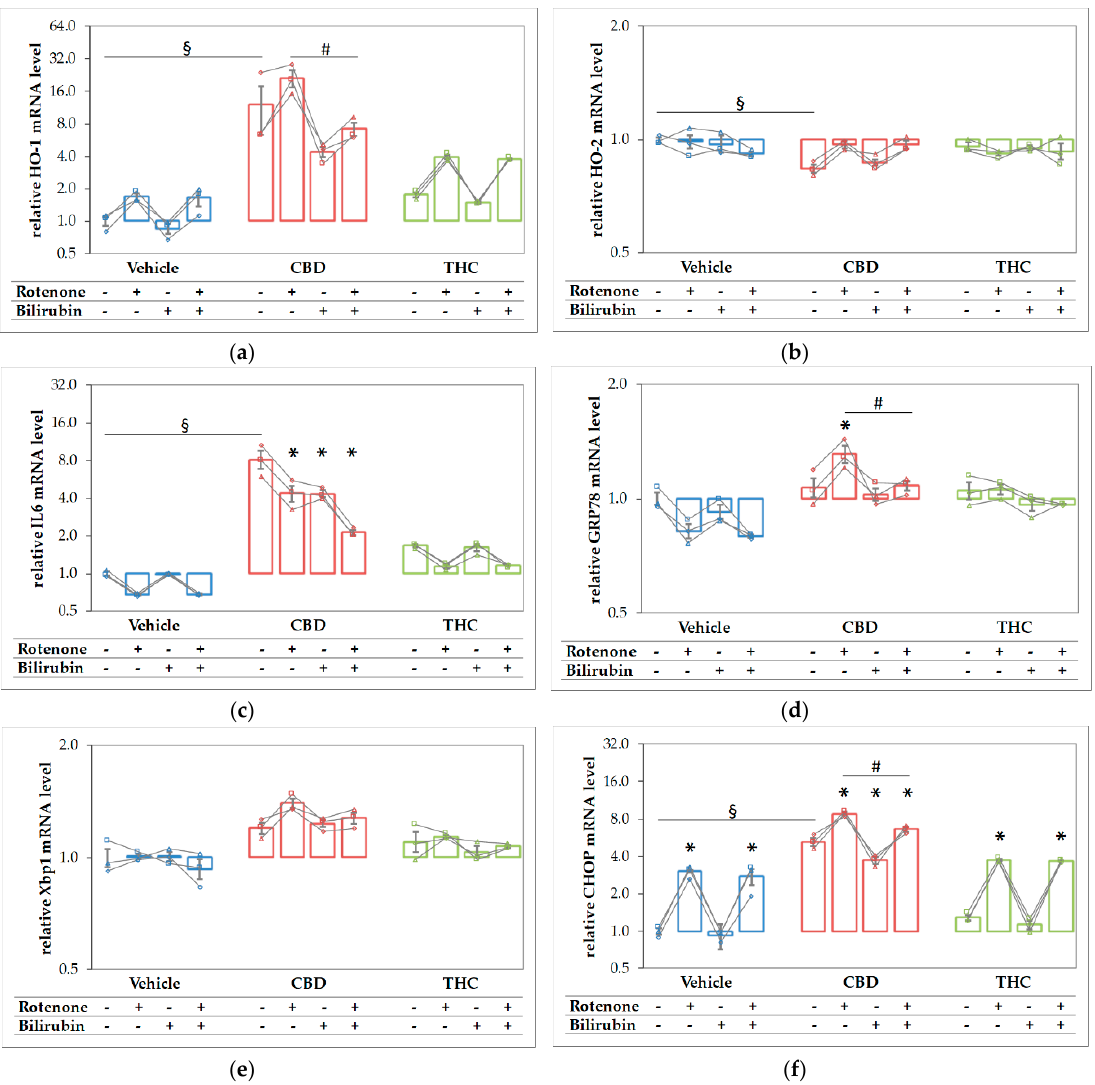
Figure 7. Rotenone and cannabidiol act synergistically in eliciting a stress response. N18TG2 cells were seeded 2 h before experiment and treated with vehicle, cannabidiol (CBD; 10 µM) or tetrahydrocannabinol (THC; 10 µ M) alone and in combination with rotenone (Rot; 80 nm) or BR (10 µ M) for 16 h. Gene expression levels of ( a ) the inducible isoform of heme oxygenase (HO-1), ( b ) the constitutive isoform of HO (HO-2), ( c ) interleukin 6 (IL6), ( d ) glucose-regulated protein 78 (GRP78), ( e ) X-box protein 1 (Xbp1), and ( f ) the pro-apoptotic marker C / EBP homologous protein (CHOP) were determined by reverse transcription-quantitative PCR, normalized to the internal reference gene Cyclophilin. Data are shown as both individual values and mean ± SEM of three biological replicates ( n = 3) and are displayed relative to the untreated control condition (vehicle control), which was set to 1. The obtained data are displayed on a logarithmic scale with the base of 2. One-way ANOVA, followed by Bonferroni was performed to calculate the di ff erences between groups. Values of p ≤ 0.05 were considered significant, and the following symbols indicate significant di ff erences to the vehicle control group (§), to the respective control group (*), and between the condition with added Rot vs. Rot + BR (#). Exact p values for the group comparisons are shown in the supplementary material (Table S6).